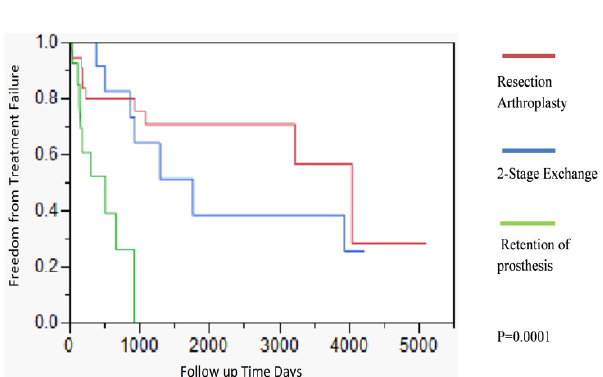
Figure 2. Kaplan-Meier time dependent analysis of Pseudomonas PJI, by type of surgical therapy. Patients with debridement and implant retention of their prosthesis had a significantly worse outcome when compared to resection arthroplasty and 2-stage